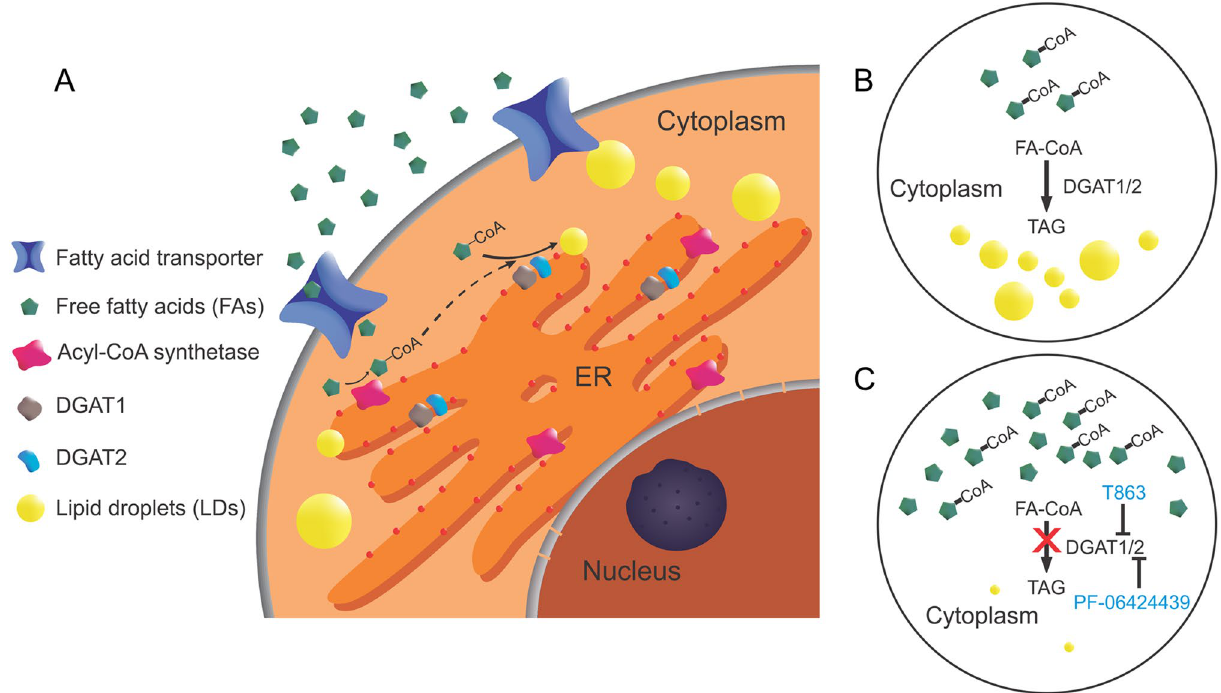
Figure 1. ( A ) Illustration of TAG synthesis and lipid droplets (LDs) formation from free fatty acids (FAs). Free FAs enter the cells through passive diffusion and fatty acid transporters and are activated into the form of acyl-CoA with the help of acyl-CoA synthetase. After further modification by related enzymes, acyl-CoA eventually forms TAG and LDs in the presence of DGAT1 and DGAT2. ( B ) The adipogenesis pathway shows the last step of lipogenesis involving enzymes DGAT1/2. TAG synthesis and LD formation are normal when DGAT1/2 are functioning properly. ( C ) Inhibition of DGAT1 and DGAT 2 using small-molecule inhibitors T863 and PF-06424439, respectively, to deplete cellular LDs. When DGAT1/2 are inhibited, TAG synthesis and LD formation are reduced, leading to increased free FAs. ER endoplasmic reticulum, DGAT diglyceride